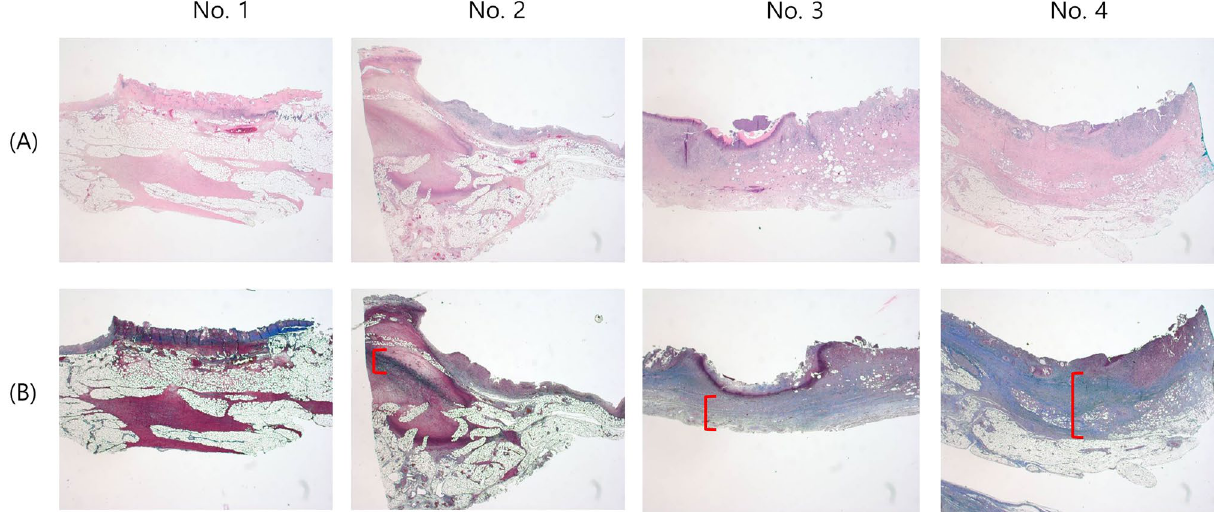
Figure 6. Histopathologic microscopic images of the APC application area of the CBD. Extensive abscesses replace the thickened wall at the APC application area of the first and second animals. Fibrosis is observed to begin in the second animal. In the third and fourth animals, abscess formation was greatly decreased, and the thickened wall is nearly replaced by fibrosis (parentheses indicate fibrosis thickness). ( A ). H&E; original magnification 40 × . ( B ) MT; original magnification 40 × .